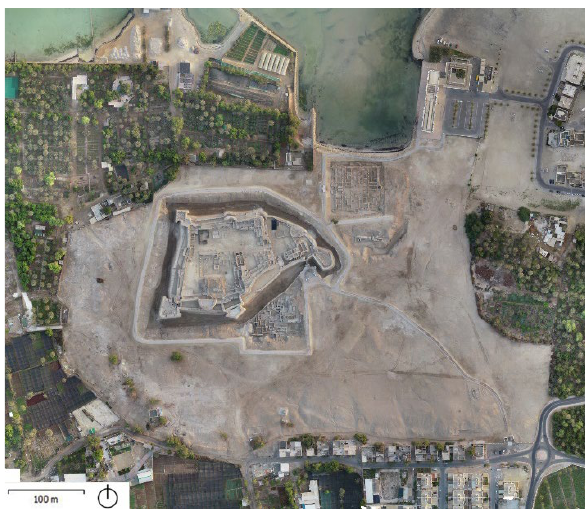
Figure 1. Orthoimage produced from unmanned aerial vehicle (UAV) photogrammetry captured at 100m flight height. It shows the forts, archaeological tell and surrounding agricultural lands, World Heritage Site property of Qal’at al-Bahrain - Ancient Harbour and Capital of Dilmun Source: authors data